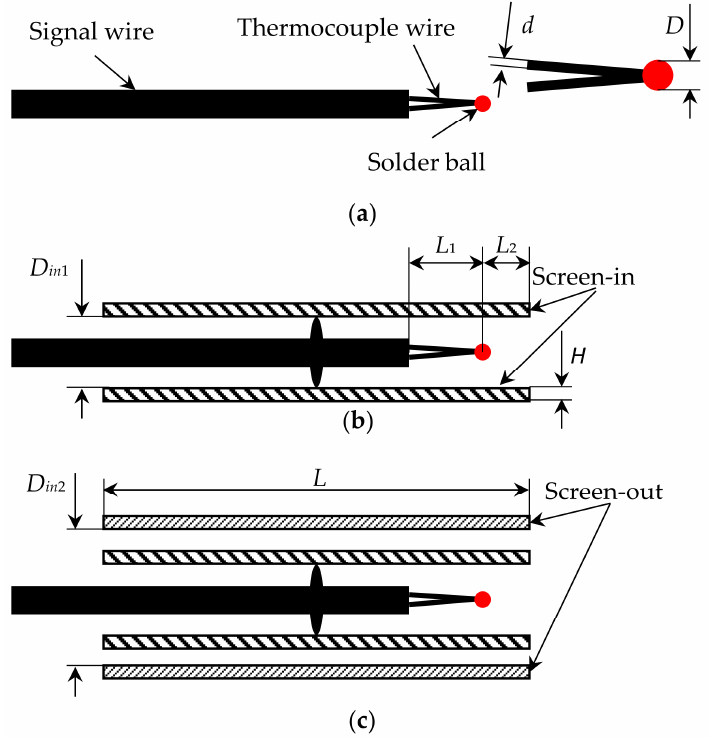
Figure 2. Three types of thermocouples with different configurations: ( a ) no-screen thermocouple (NST), ( b ) single-screen thermocouple (SST), ( c ) dual-screen thermocouple (DST).